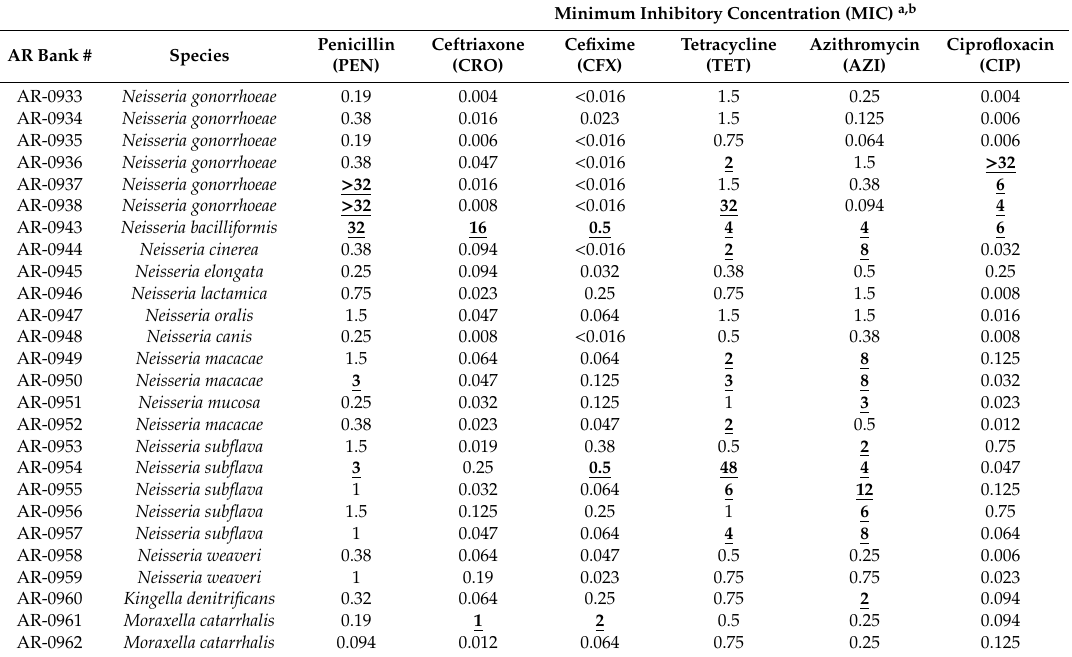
Table 1. Minimum inhibitory concentrations of Neisseria spps. measured by